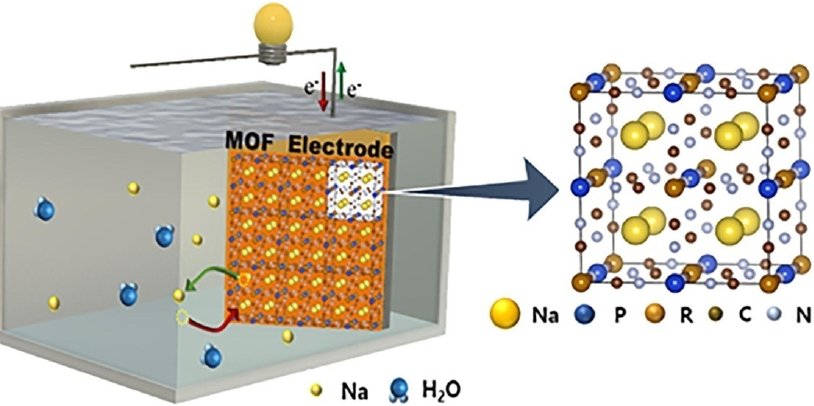
Figure 16. MOFs as electrode materials for aqueous sodium-ion rechargeable batteries (ASIBs) [78]. Reproduced with permission.